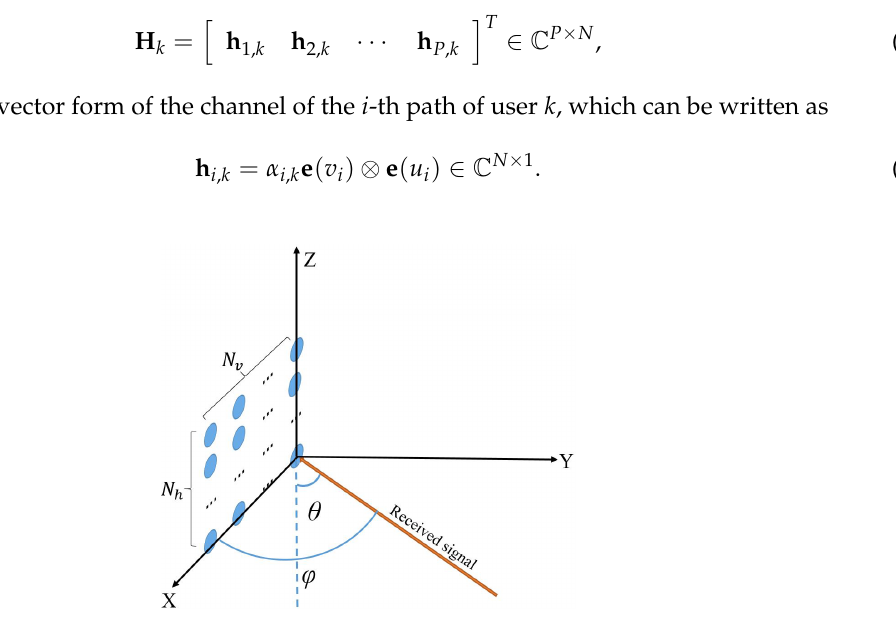
Figure 1. Received signal model. The number of base station antennas is N = N v × N h , θ is the pitch angle of receiving signal, and ϕ is the azimuth